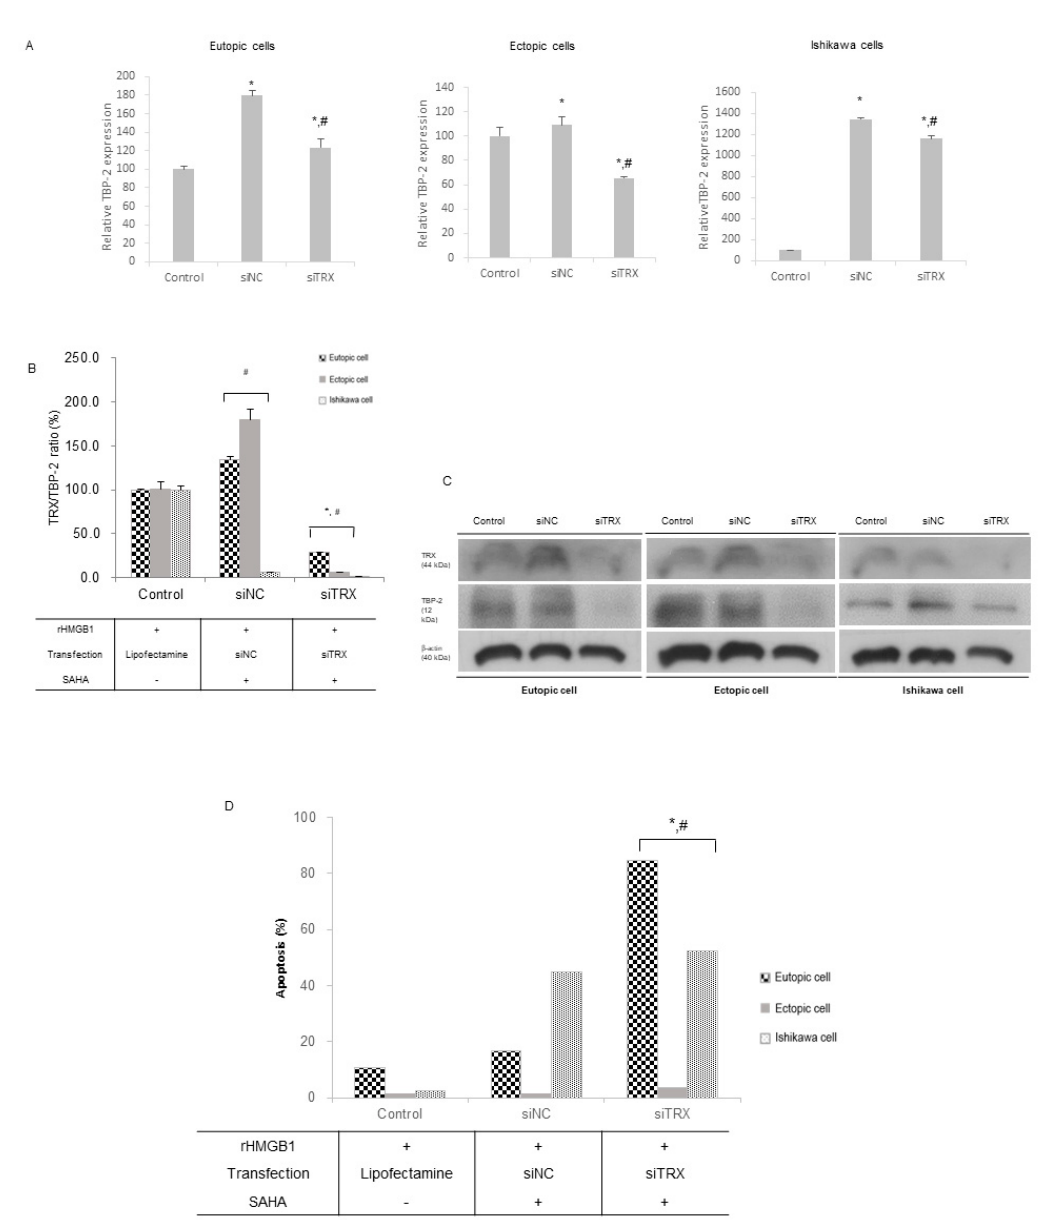
Figure 3. Changes after oxidative stress in siTRX transfected endometrial cells. The cells were treated with 10 mg/mL of rHMGB-1 for 24 h, followed by 2.5 μ M SAHA treatment for 48 h. ( A ) The mRNA expression of TBP-2 was modified after siTRX transfection. ( B ) The TRX/TBP-2 ratio of mRNA expression revealed a significant decrease in siTRX-transfected cells. ( C ) Western blot was concordant with RT-PCR result. ( D ) Apoptosis was significantly increased in siTRX -transfected cell treated with SAHA, compared to non-SAHA-treated cells (control), and siNC (negative control) cells, respectively. *, p < 0.05 compared to the control; #, p < 0.05 compared to siNC.